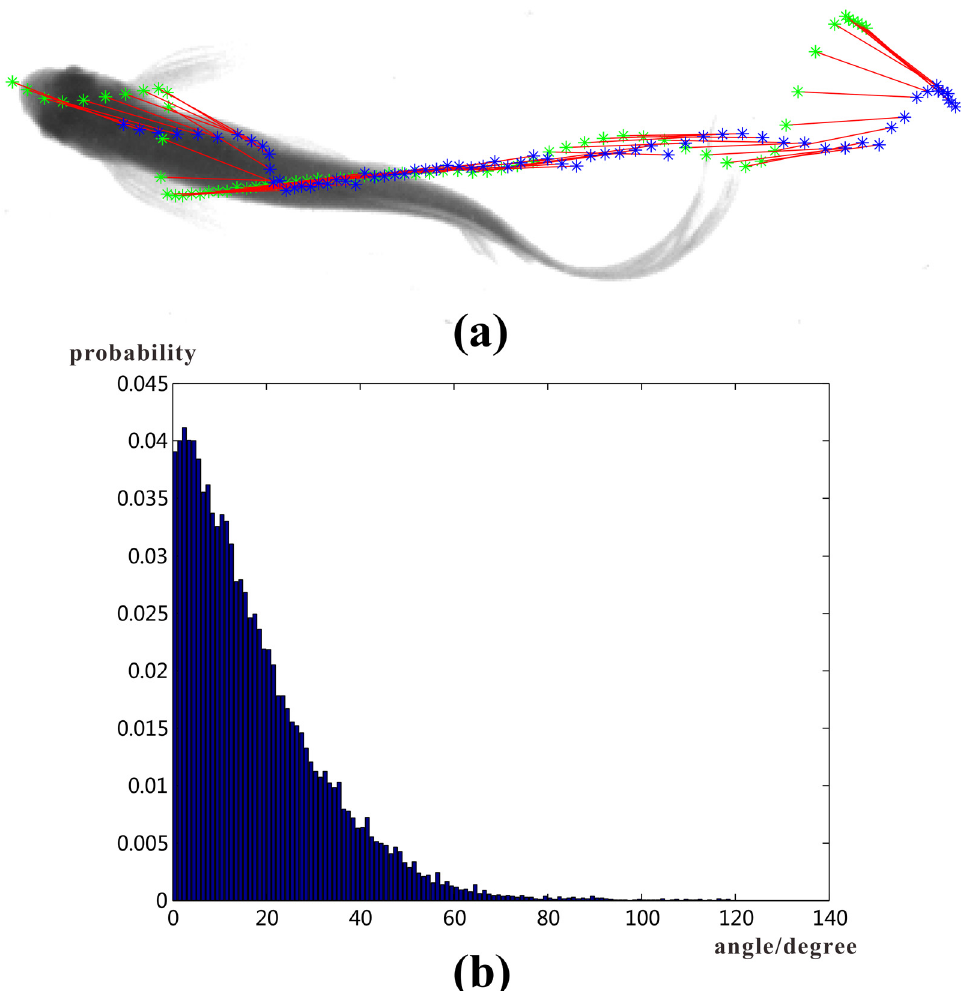
Fig 9. Discussion of tracking result. (a). Trajectory of a fish ’ s nose point and J 1 . Green dots plot the trajectory of nose point N in consecutive frames, blue dots plot the trajectory of J 1 ; (b). Angle difference distribution of fish velocity direction and its head orientation. X-axis is the angle interval in degree, Y-axis is the possibility of angle between fish head orientation and its velocity direction dropping in the angle